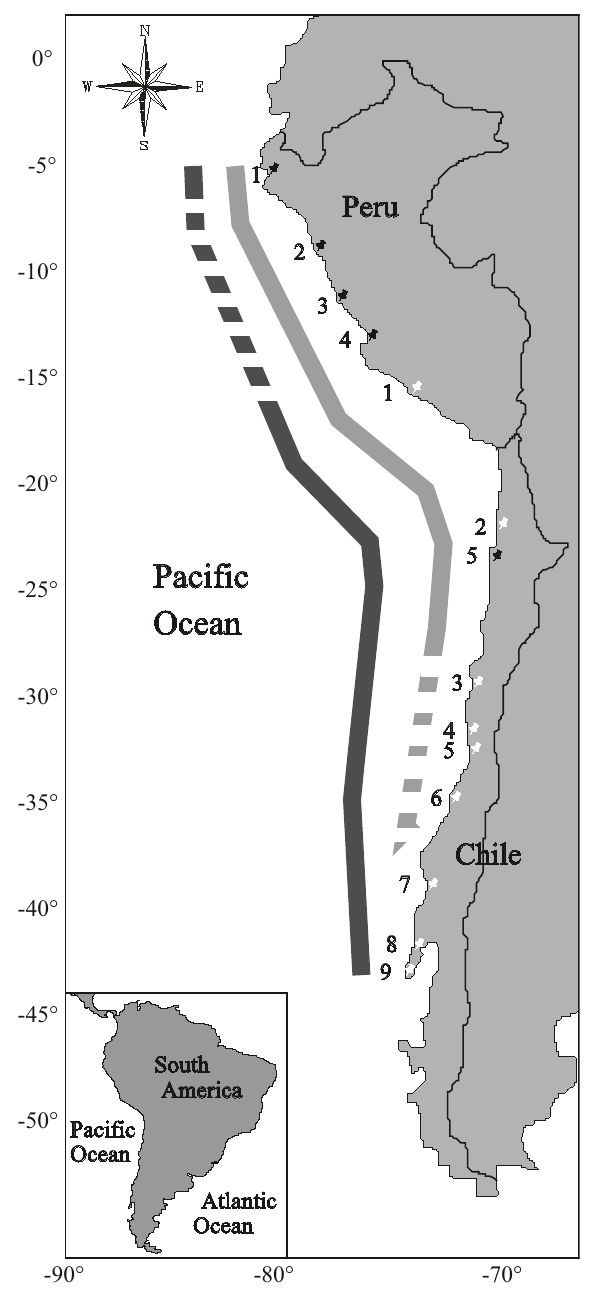
Fig . 1. – Map of South America showing the local populations of the species included in this study and their distribution range. White symbols, M. donacium ; localities: 1, Camaná; 2, Hornitos; 3, Peñue- las; 4, Longotoma; 5, La Ligua; 6, Capellanía; 7, Mehuín; 8, Cucao; 9, Quilanlar. Black symbols, A. purpuratus ; localities: 1, Paita; 2, Chimbote; 3, Callao; 4, Pisco; 5, Antofagasta. Dark grey line, A. purpuratus . Grey line, M. donacium . Bold sector lines indicate the current distribution, while dotted sector lines show the historical